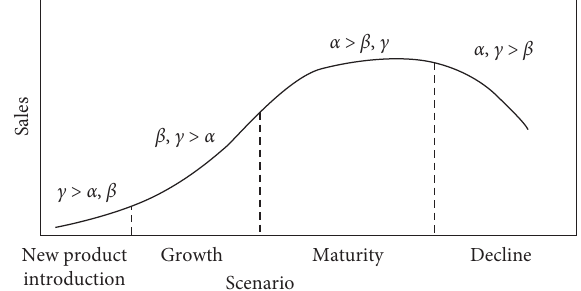
Figure 8: Model parameter setting in different